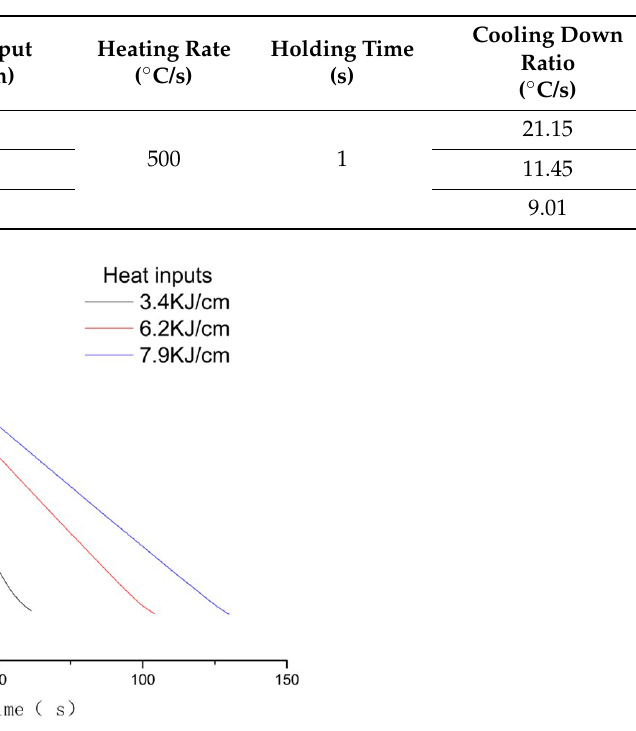
Figure 2. Thermal cycle of Gleeble